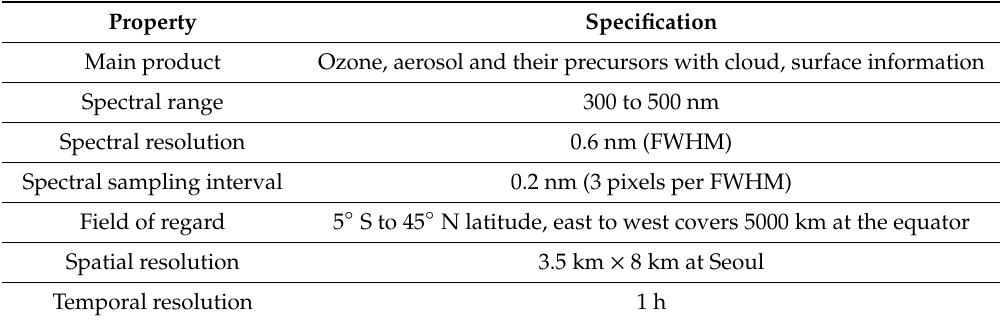
Table 1. Summary of GEMS top-level